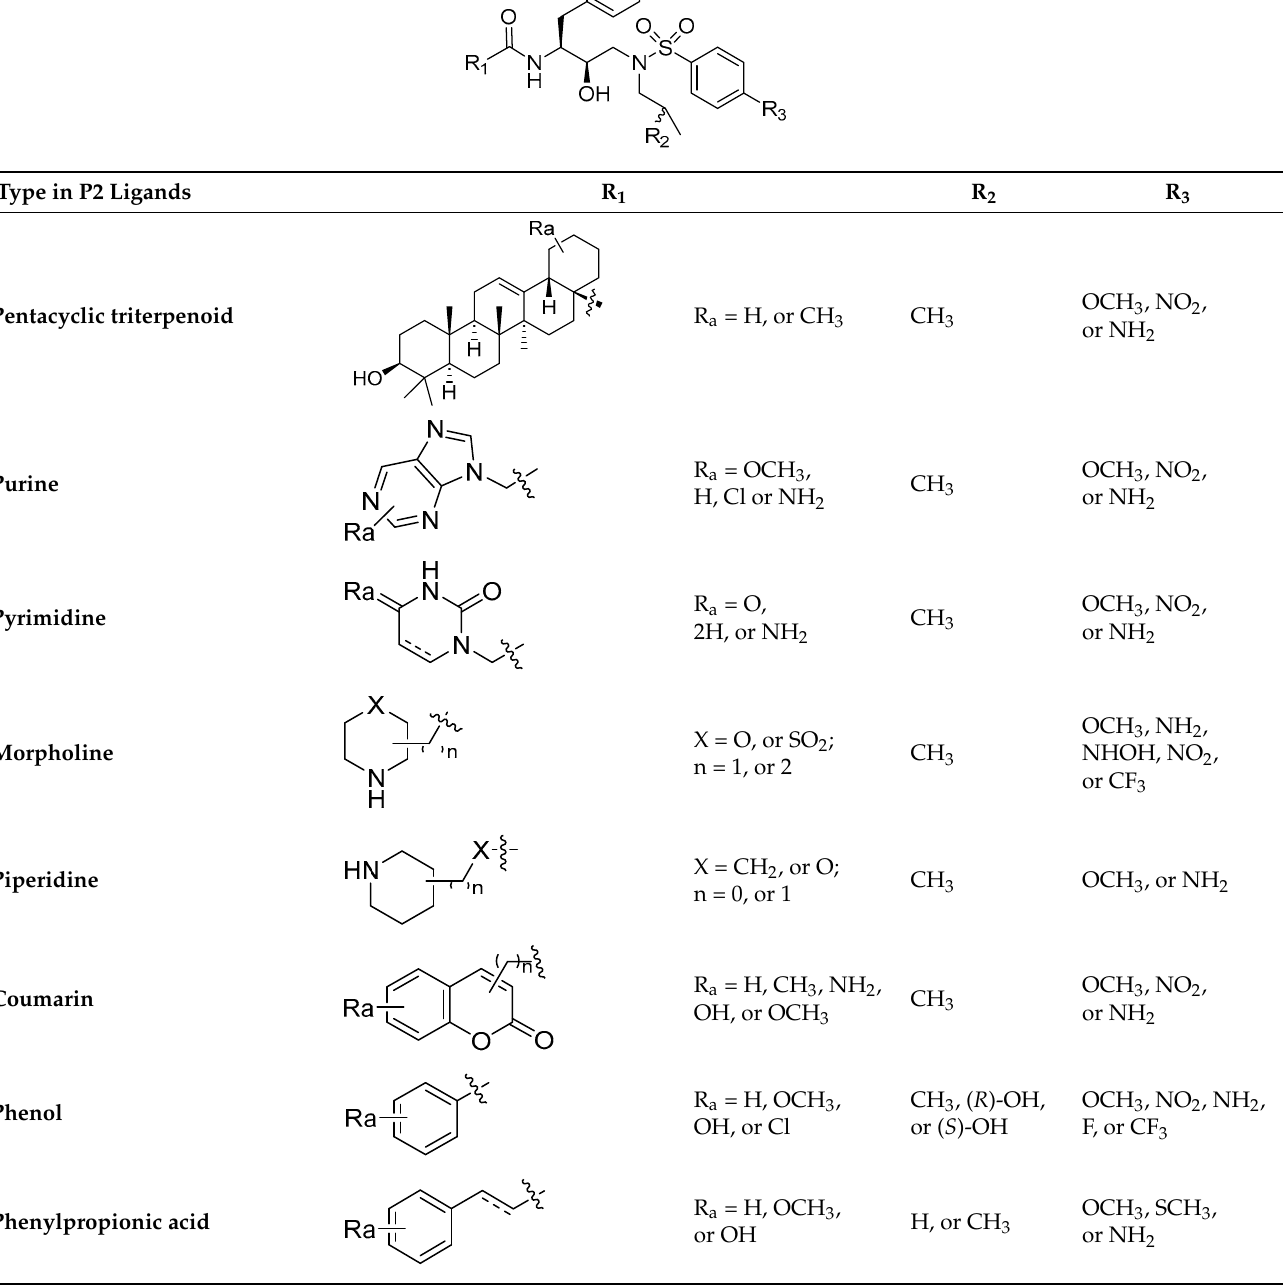
Figure 2. Results of the high-throughput screening. Twenty μ M of the compounds was pre-incu- bated with 100 nM of SARS-CoV-2 3CL pro for 30 min at 30 °C, and then a 10 μ M FRET substrate was added to the reaction mixture to initiate the reaction. The reaction was monitored for 2 h. The initial velocity was calculated by linear regression using the data points from the first 15 min of the reac- tion. The calculated initial velocity with each compound was normalized to DMSO control. The results are the average of three repeats. 2.3. The Inhibitory Activity of Hits against SARS-CoV-2 3CL pro In Vitro To verify the screening results, we further characterized the inhibitory activities of these hits against SARS-CoV-2 3CL pro in a dose-response experiment to determine their IC 50 values. The FRET values were measured, and the inhibitory rates were calculated for the inhibitor treatments compared to the DMSO control, which was then plotted as dose- response curves for determining the inhibitor efficacies of the IC 50 values. The results showed that nirmatrelvir and ebselen could dose-dependently inhibit the enzymatic ac- tivity of the 3CL pro with an IC 50 value of 3.24 μ M and 3.60 μ M (Figure 3), which are com- parable to the reported IC 50 value. We also observed a gradual decrease in the cleavage efficacy of the 3CL pro under the treatment of our hits (29# and 50#) with an IC 50 value of 6.30 μ M and 3.50 μ M, respectively. As a counter screen, we measured the activity of 29# and 50# against Cathepsin L, a member of the lysosomal cysteine protease [32]. The result showed that both the compounds exhibited a very limited inhibitory effect (Figure S1), providing evidence to support the specific activity of 29# and 50# against the 3CL pro .